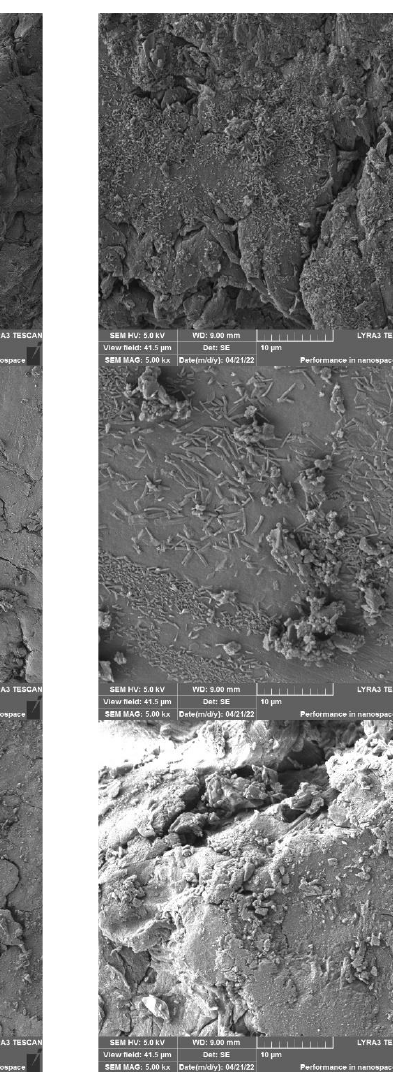
Figure 8. Dissolution profiles of granulates prepared by impregnating thin MCC tablet by MX in 7 cycles ■ , 14 cycles ■ and 27 cycles ■ .